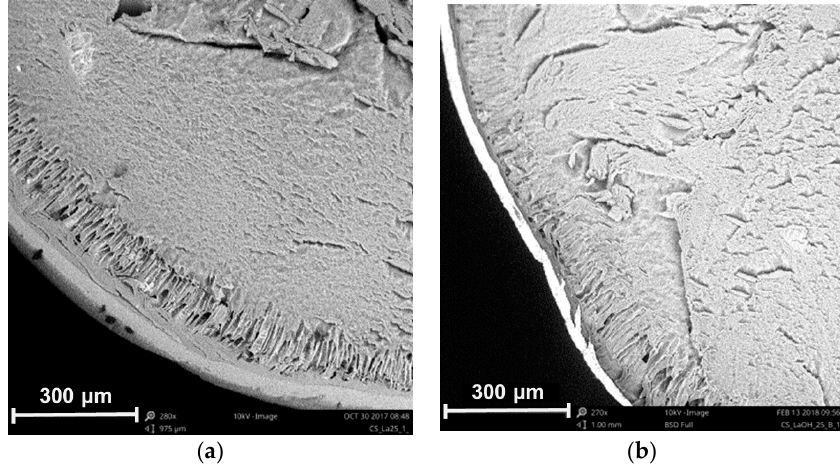
Figure 2. The SEM images of cross-section of chitosan hydrogel beads attached with La(III): ( a ) La-CTS before adsorption and ( b ) La-CTS-B after boron adsorption.